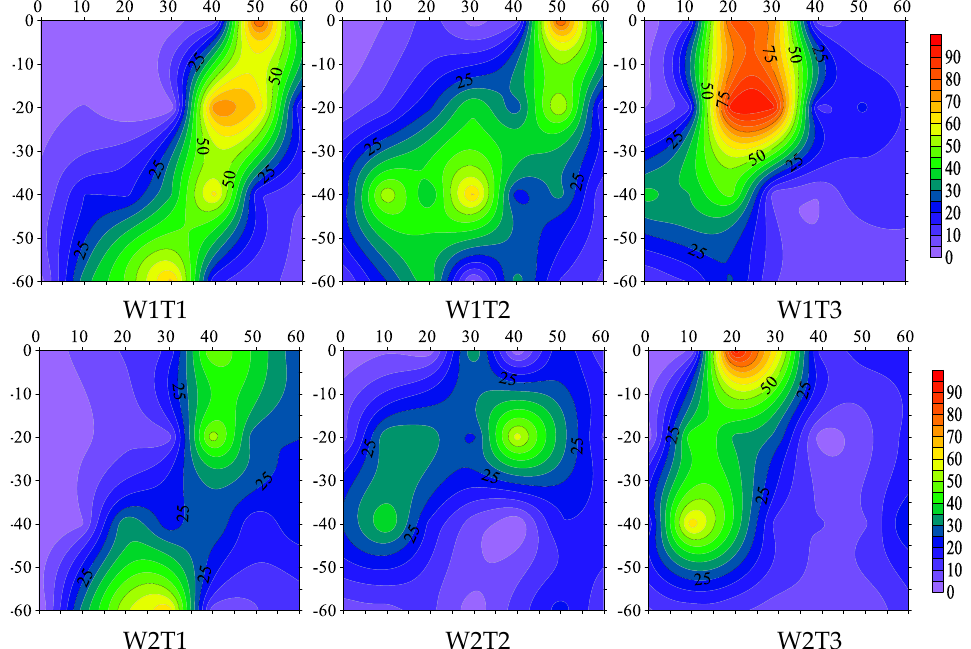
Figure 3. Distribution of soil NO 3 − -N (mg kg − 1 ) after irrigation and fertilization on March 22nd: Point (0,0) is the position of the emitter. W1T1 = fertilization time at the beginning of 30 mm irrigation rate; W1T2 = fertilization time in the middle of 30 mm irrigation rate; W1T3 = fertilization time at the end of 30 mm irrigation rate; W2T1 = fertilization time at the beginning of 20 mm irrigation rate; W2T2 = fertilization time in the middle of 20 mm irrigation rate; W2T3 = fertilization time at the end of 20 mm irrigation rate. Values represent means ( n = 3). Table 2. Soil NO 3 − -N ratios at different layers in different treatments at the wheat jointing stage. Soil Treatment